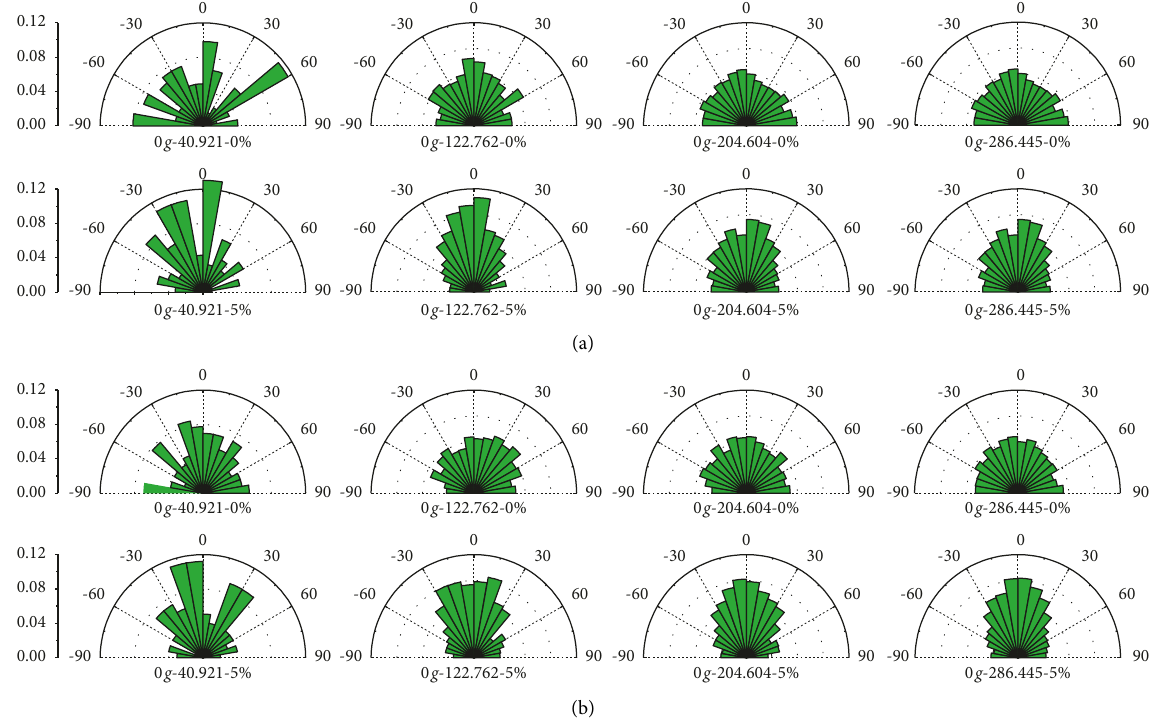
Figure 12: Evolution of orientation degree of void cell in RVEs under 0g gravity. (a) Size effect caused by RVE height. (b) Size effect caused by particle